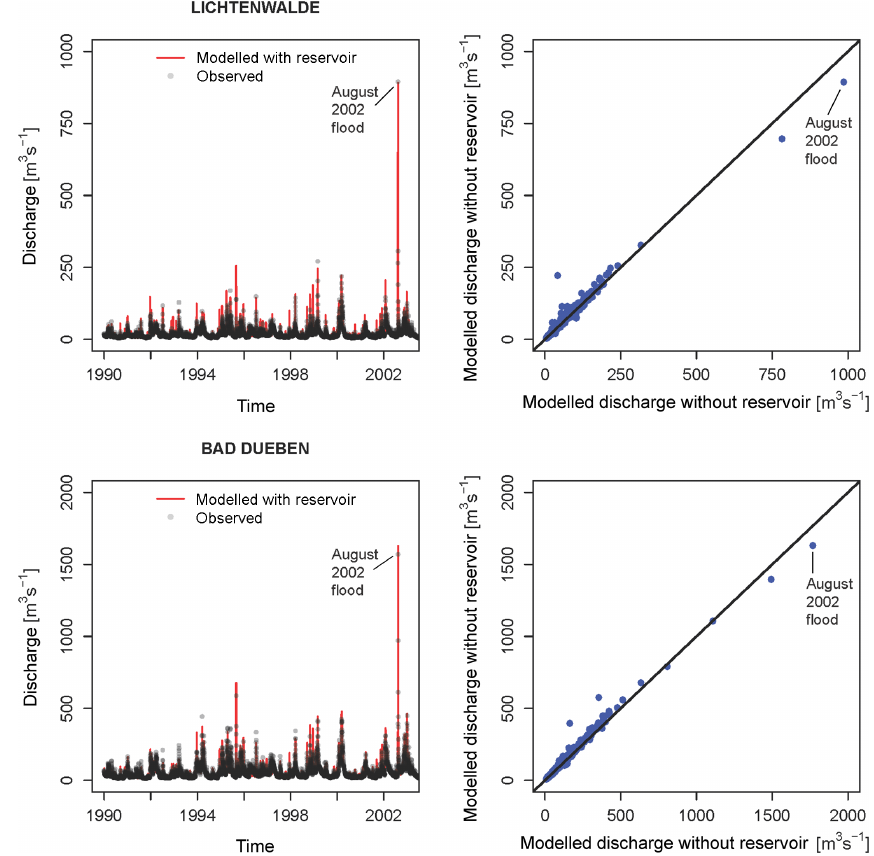
Figure 3. Model performance of SWIM at selected gauging